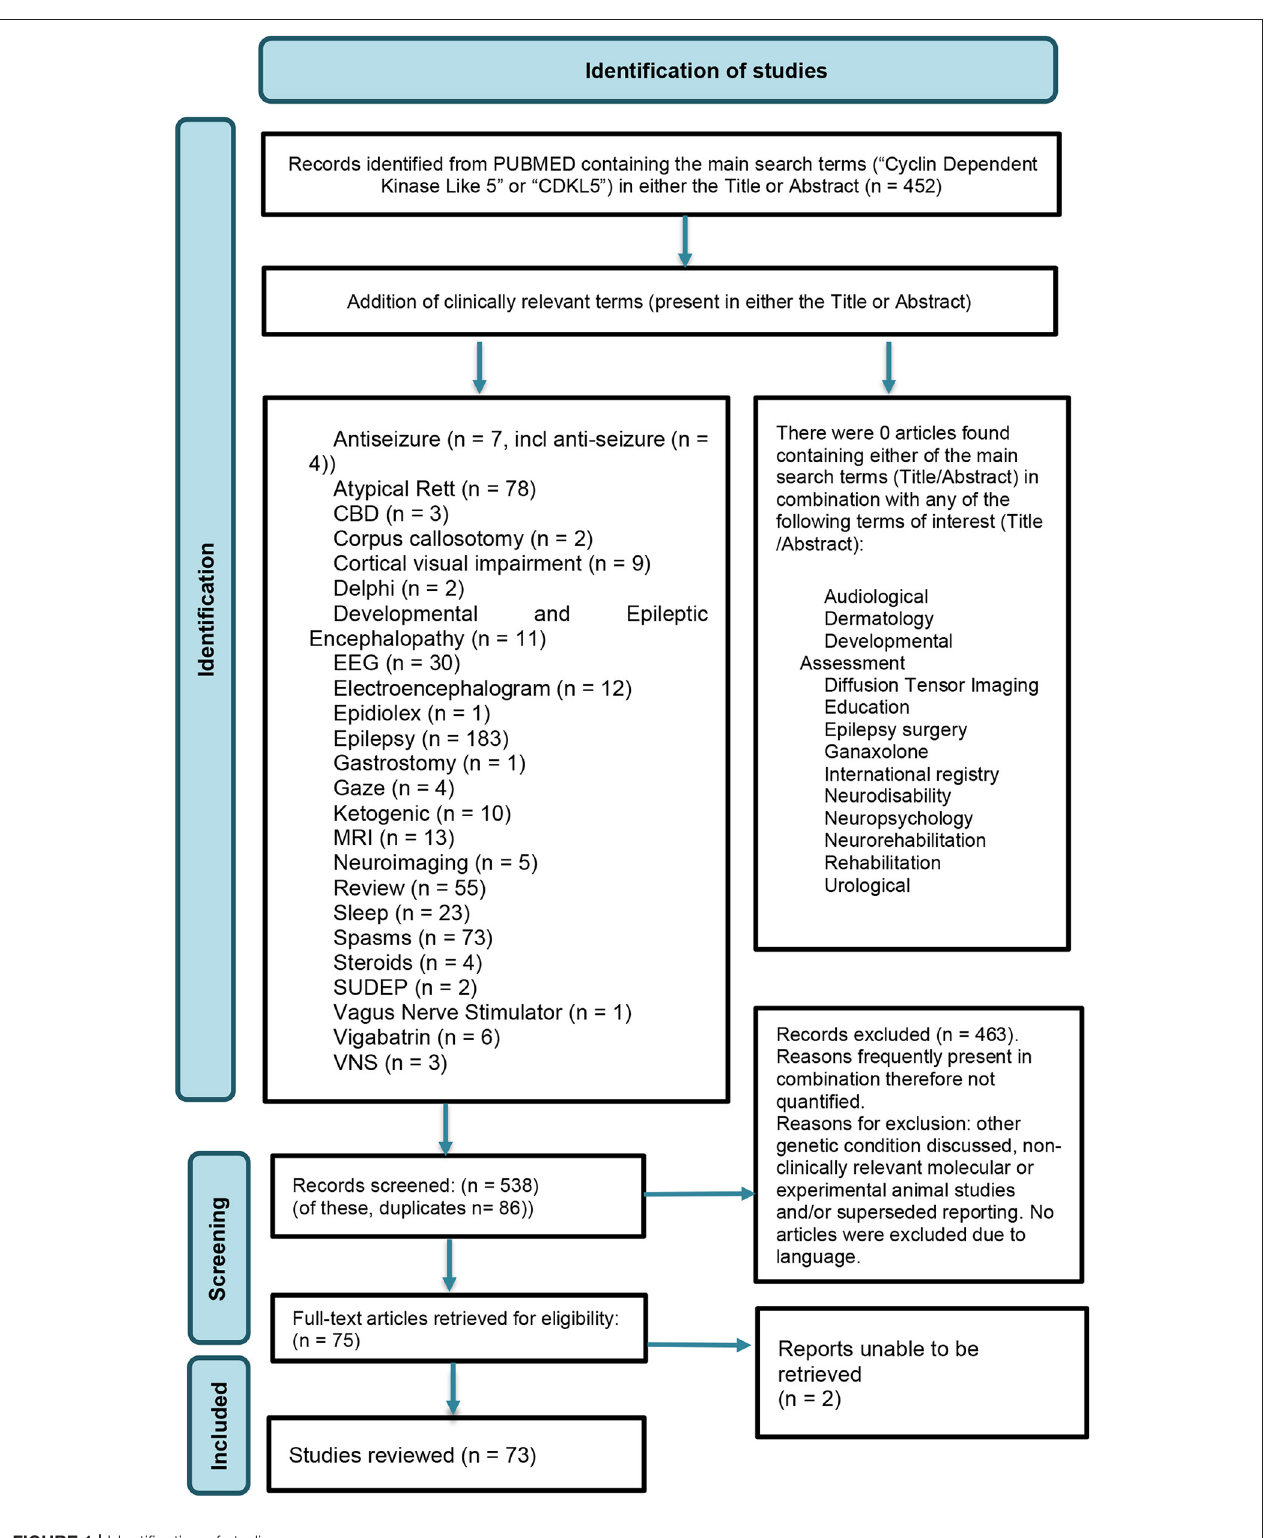
FIGURE 1 | Identification of